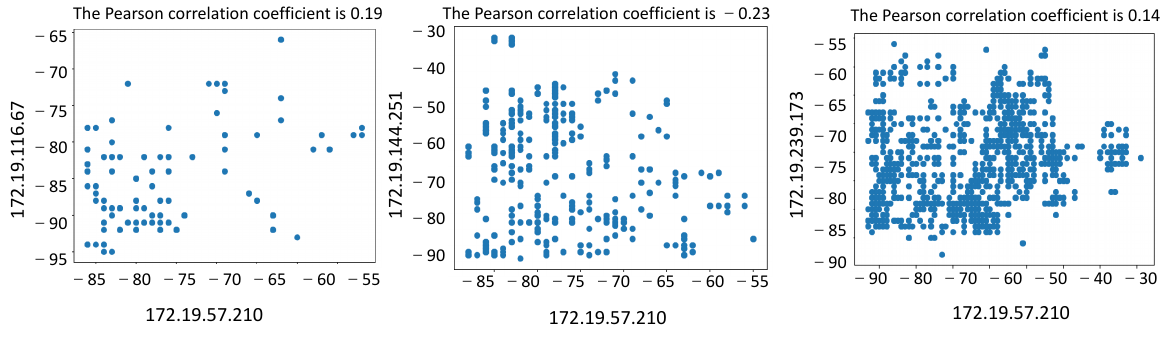
The Pearson correlation coefficient is 0.14 The Pearson correlation coefficient is 0.19 The Pearson correlation coefficient is － 0.23